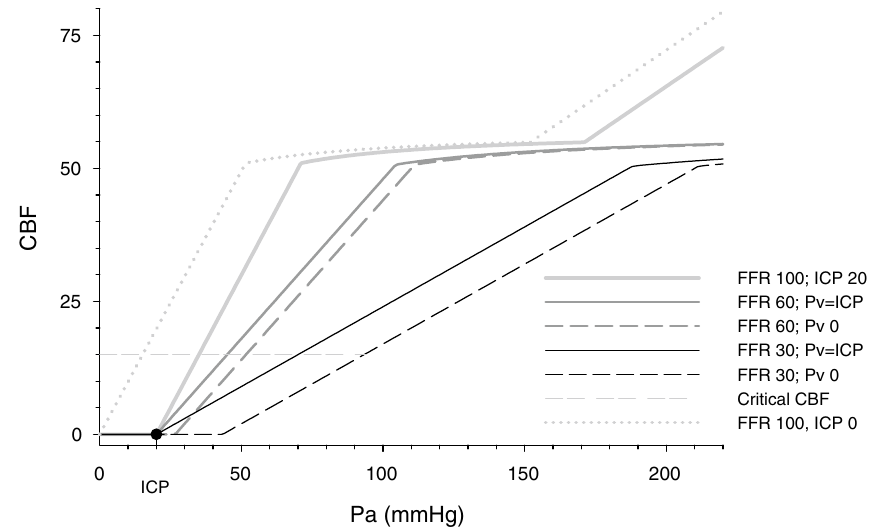
Figure 6. Simulated autoregulation curve (AC) with and without intra-extracranial flow diversion. Simulated autoregulation limits 50–150 mmHg and maximally vasoconstricted to vasodilated intracranial compartment resistance ratio 2.2. Increased intracranial pressure (ICP) and inflow stenosis (FFR) transform AC differently: increased ICP (20 mmHg shown) shifts AC to the right by the value of ICP, while inflow stenosis flattens not autoregulated portion of AC, without altering zero flow pressure. Steal manifests only when intra-extra cranial outflow pressure gradient ICP-Pe coexists with decreased FFR, and it shifts AC (that is already flattened by inflow stenosis) to the right of ICP. These effects are relevant during the low flow states caused by hypotension, severe extracranial stenosis, and high ICP. In this simulation to maintain flow above the critical level with FFR 30 and ICP 20 mmHg, Pa has to exceed 100